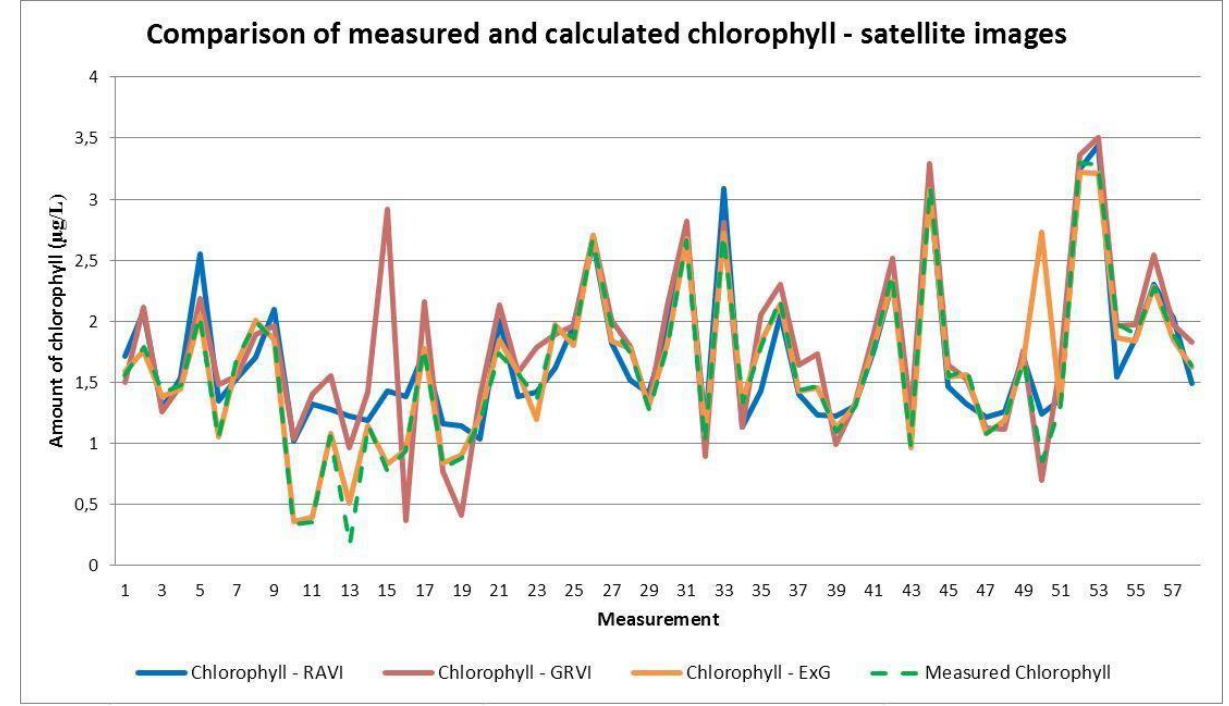
Figure 3 Comparison of measured and calculated chlorophyll – satellite images weighted averages calculated, where the chlorophyll values were mostly an inverse value of